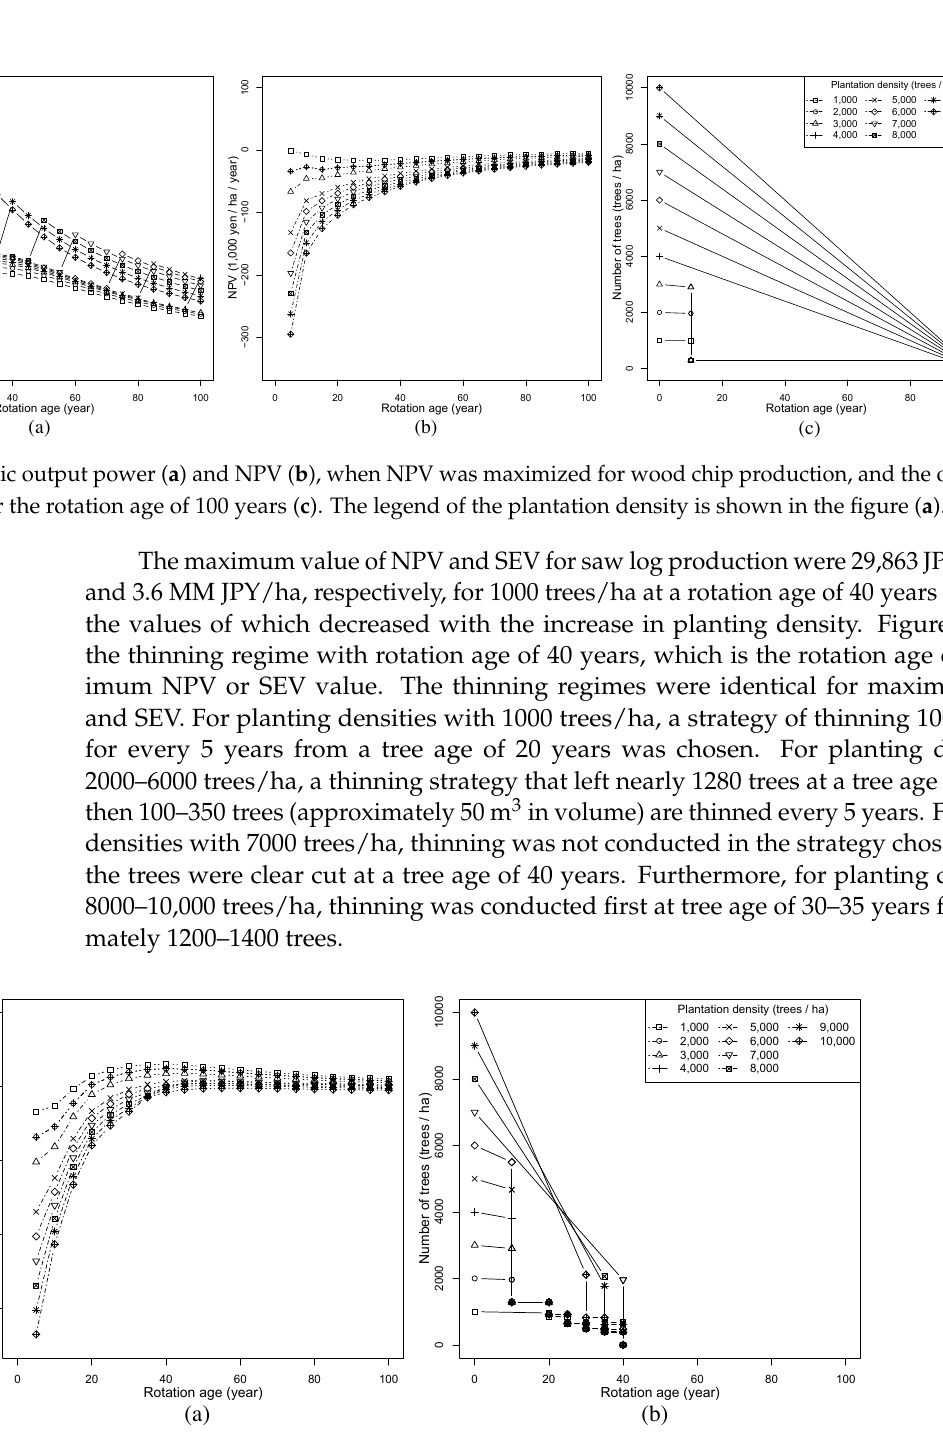
Figure 3. The NPV when the NPV was maximized for saw log production ( a ). The optimal thinning regime for the rotation age of 40 years ( b ). The legend of the plantation density is shown in the figure ( a